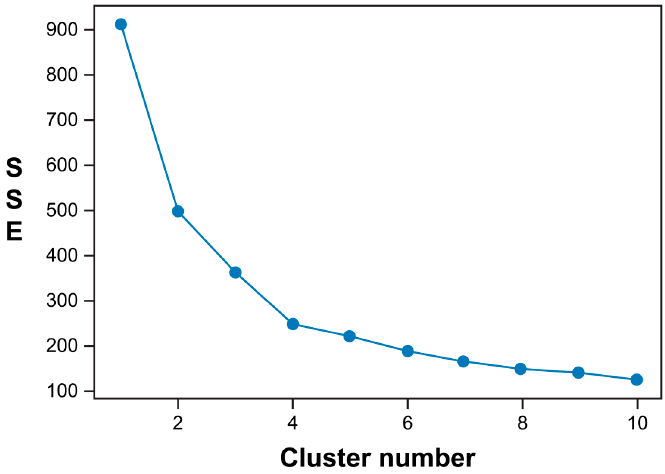
Figure 7. Results of the elbow technique for determining the optimal number of clusters.